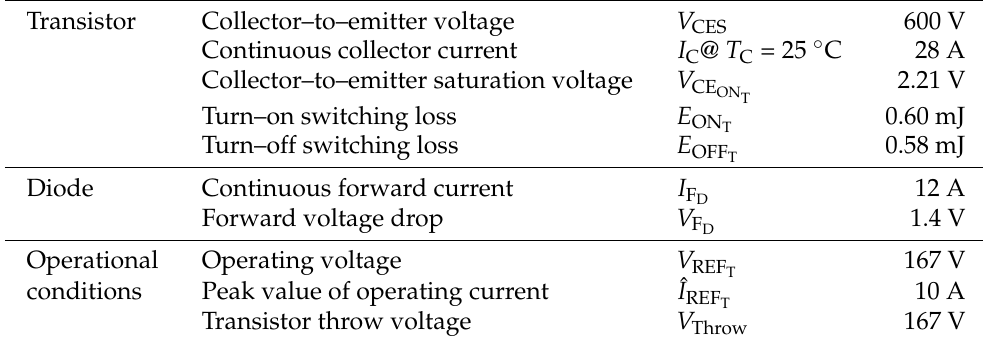
Table 2. Nominal parameters of the IGBT and Diode part number: IRG4BC30KDPbF and opera- tional conditions.